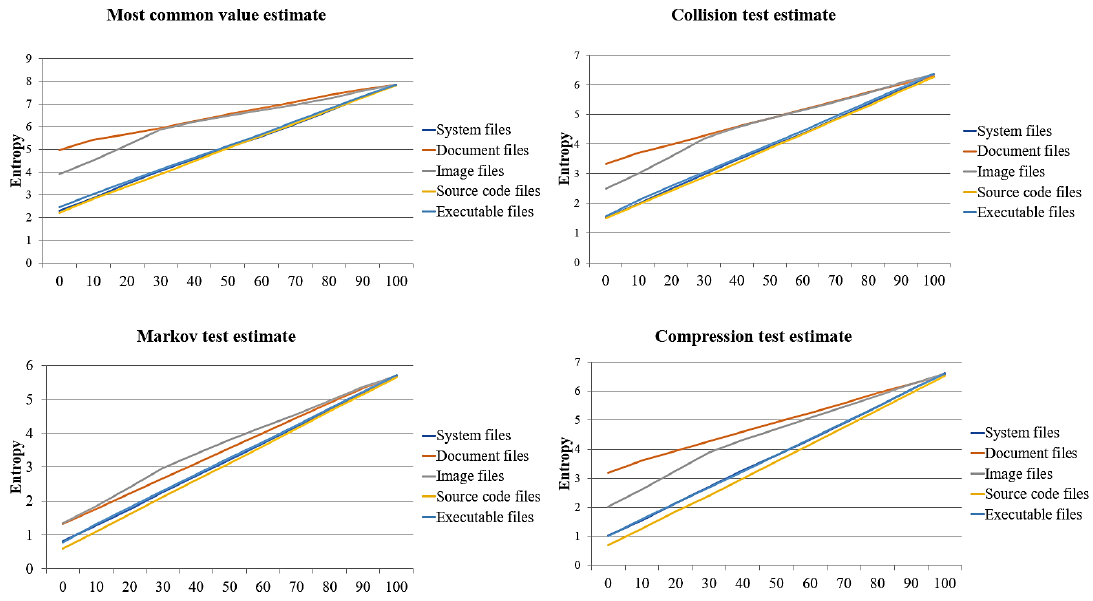
Figure 7. Changes in the entropy estimate per 10 infected files by the estimate method.